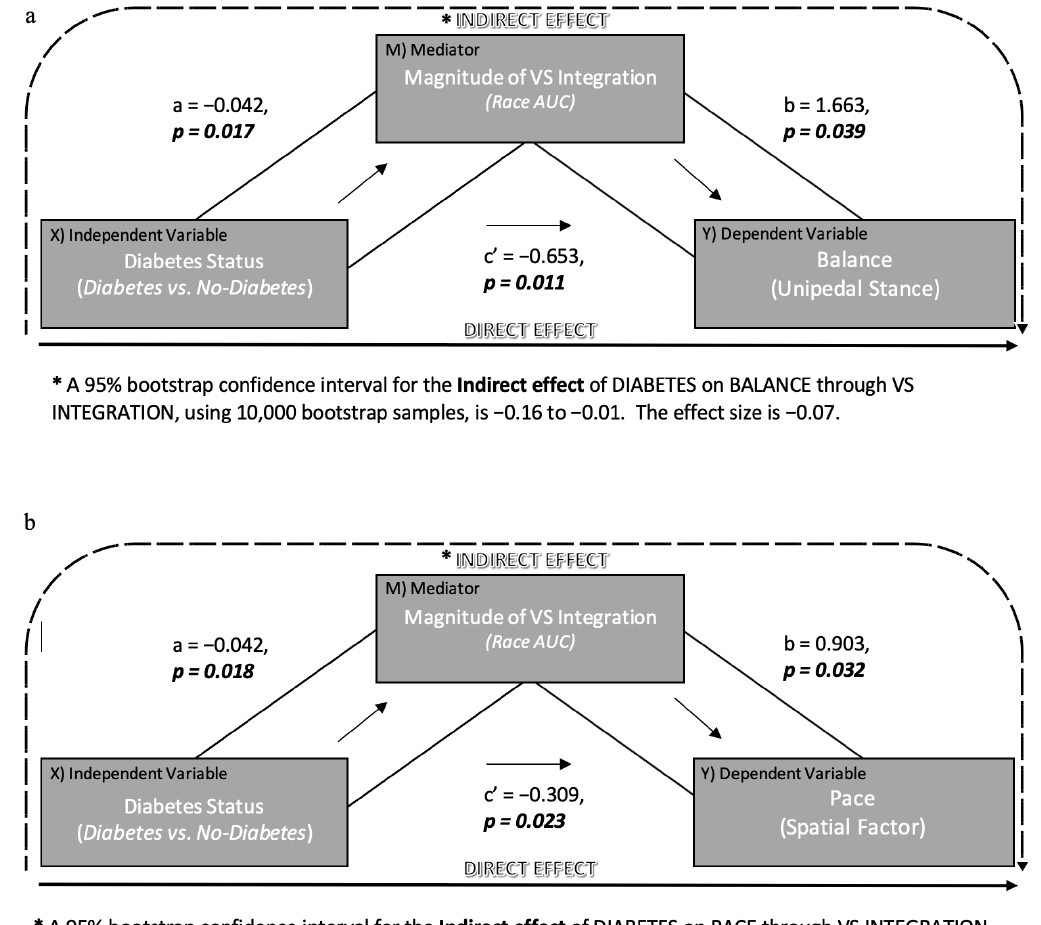
Figure 3. Mediation Analyses. Mediation models along with the results for ( a ) the influence of diabetes on balance through magnitude of VS (visual–somatosensory) integration and ( b ) the influence of diabetes on spatial aspects of gait through magnitude of VS integration AUC: